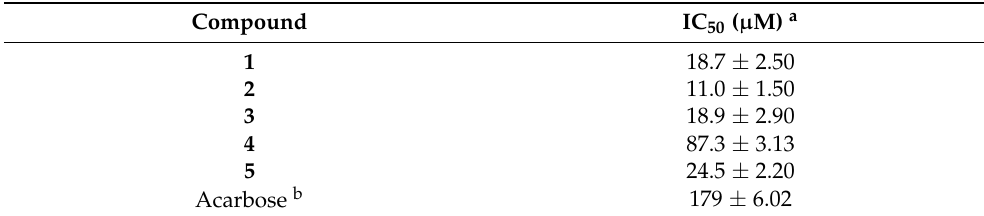
Table 2. α -Glucosidase inhibition of 1 – 5 .